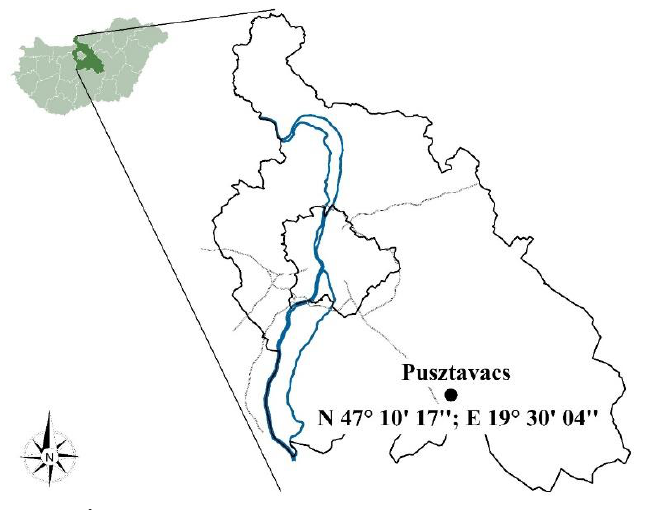
Figure 1. Location of Pusztavacs 215 E forest